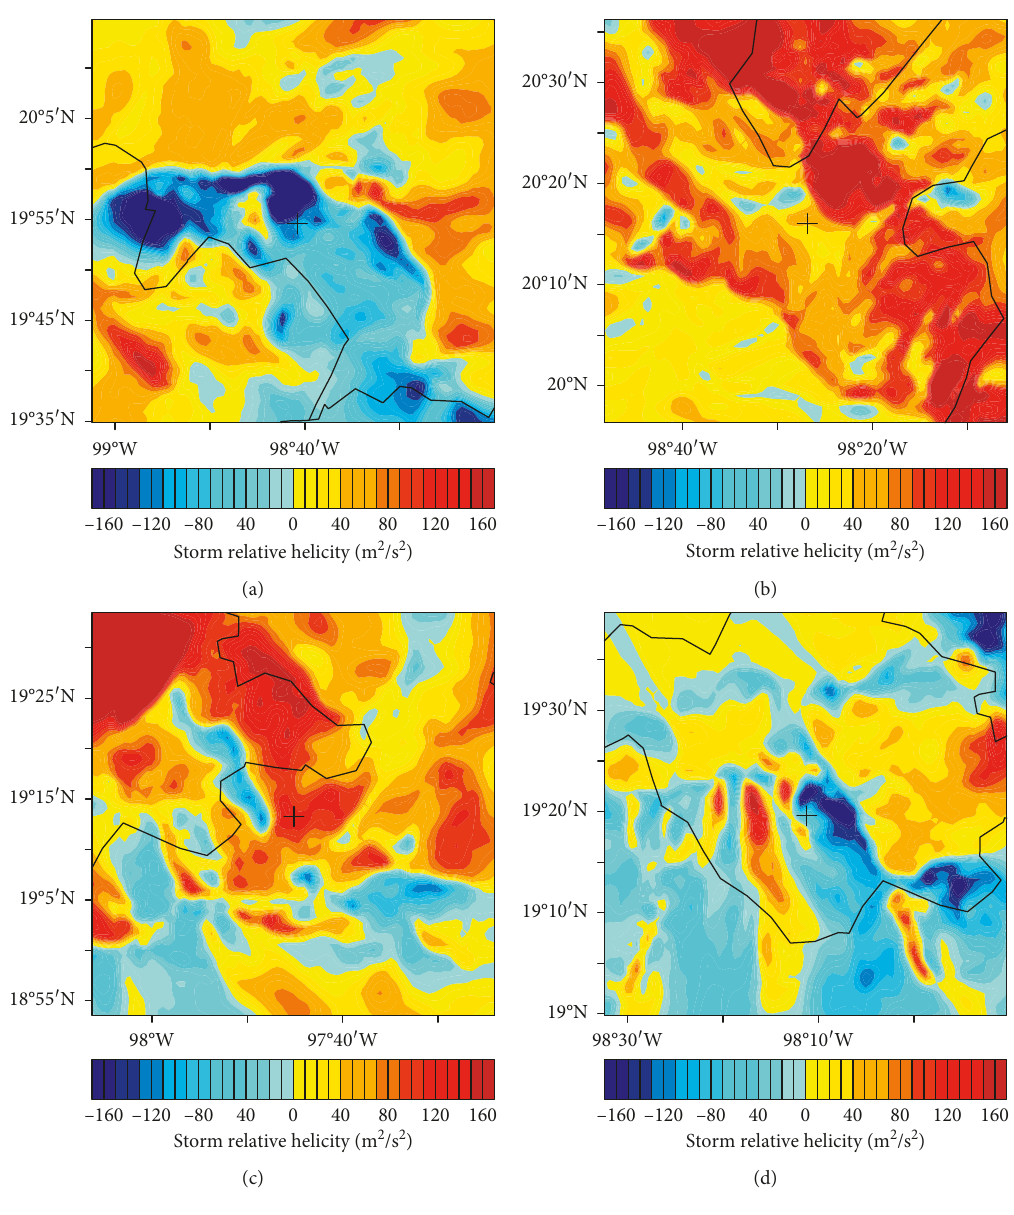
Figure 6: Storm relative helicity integrated between 0 and 1km for anticyclonic tornadoes I.D. 2 (a), I.D. 6 (b), I.D. 7 (c), and I.D. 9 (d) in domain D3 (Table 1 for I.D. numbers). The black crosses indicate the position of the